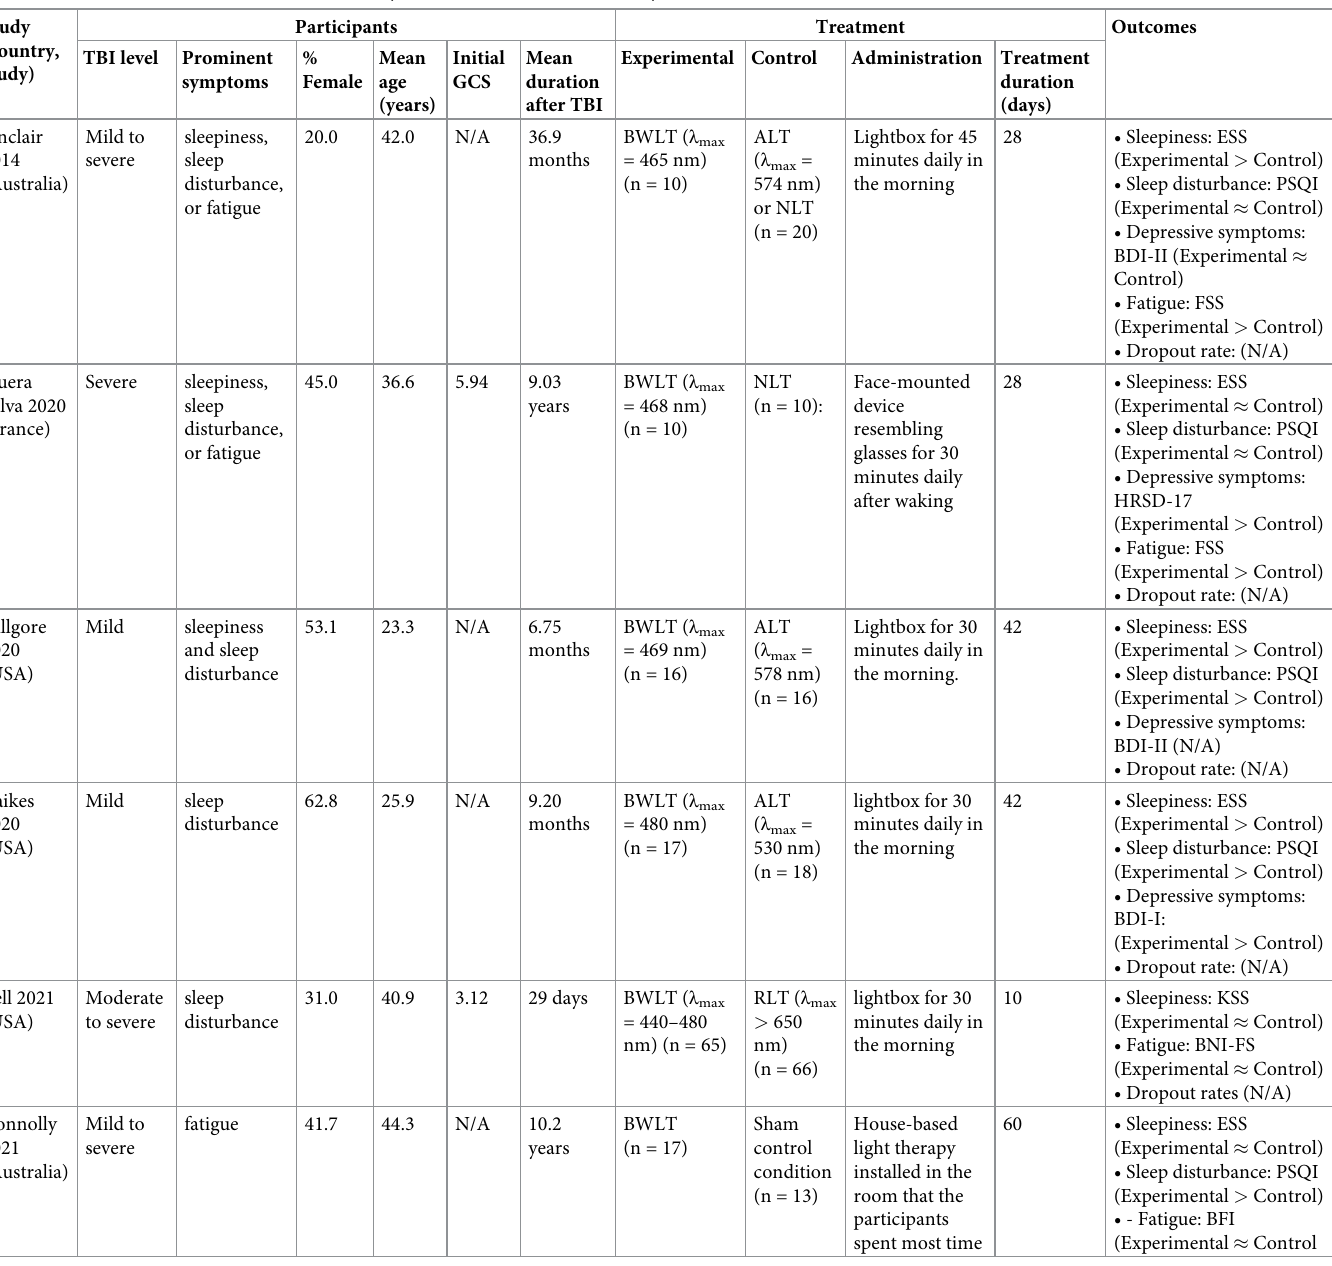
Table 1. Characteristics of trials included in the systematic review and meta-analysis � ,† .